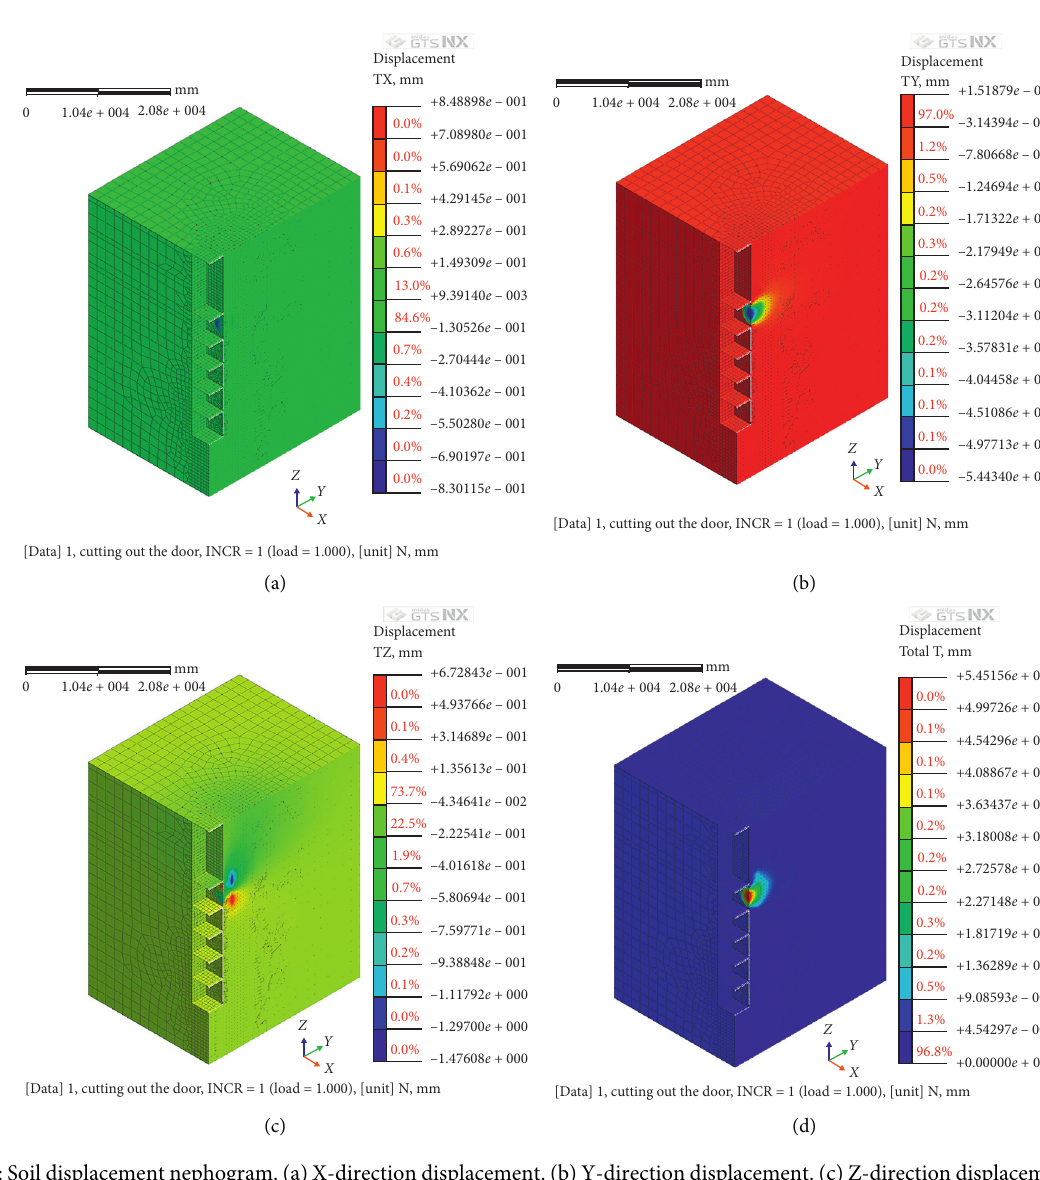
Figure 4: Soil displacement nephogram. (a) X-direction displacement. (b) Y-direction displacement. (c) Z-direction displacement. (d) Total